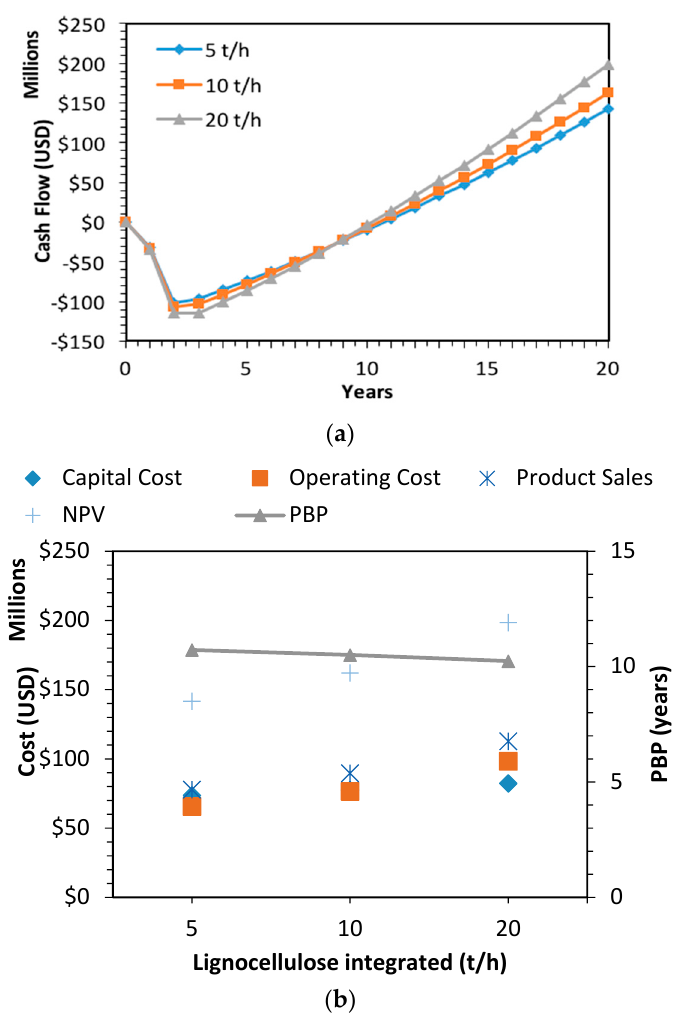
Figure 6. Cash flow diagram ( a ) and economic indexes ( b ) for the sensitivity analysis.